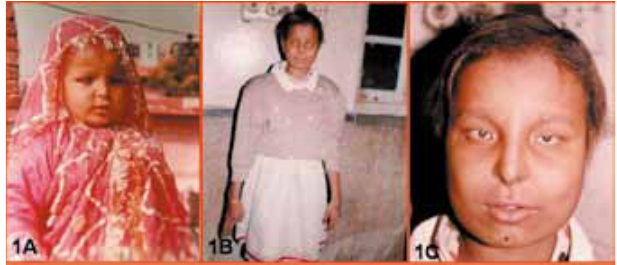
Fig. 1. Photograph of the patient at age one year (1A) and 16 years (1B and 1C) showing hypotrichosis and pili annulati. The face is small with narrow eyes, thin nose, prominent columella and wide mandible. The fingers are underdeveloped and